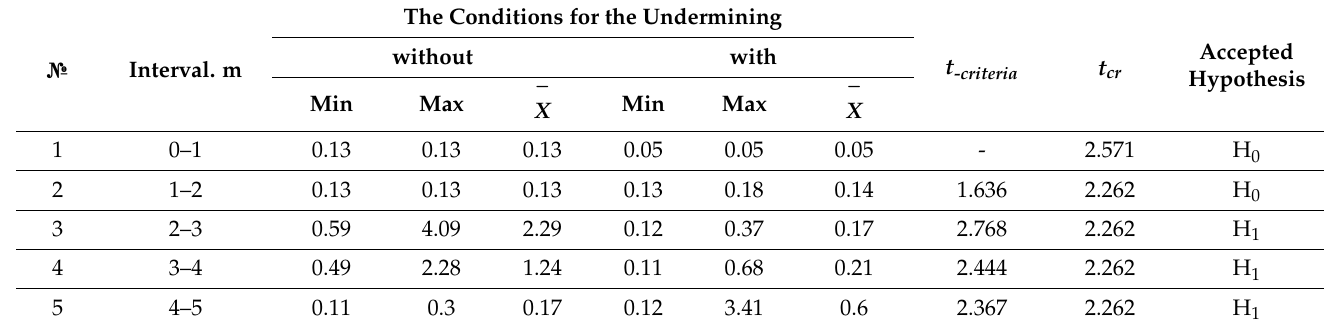
Table 4. The results of the statistical analysis of the experimental studies of the gas content of the camera